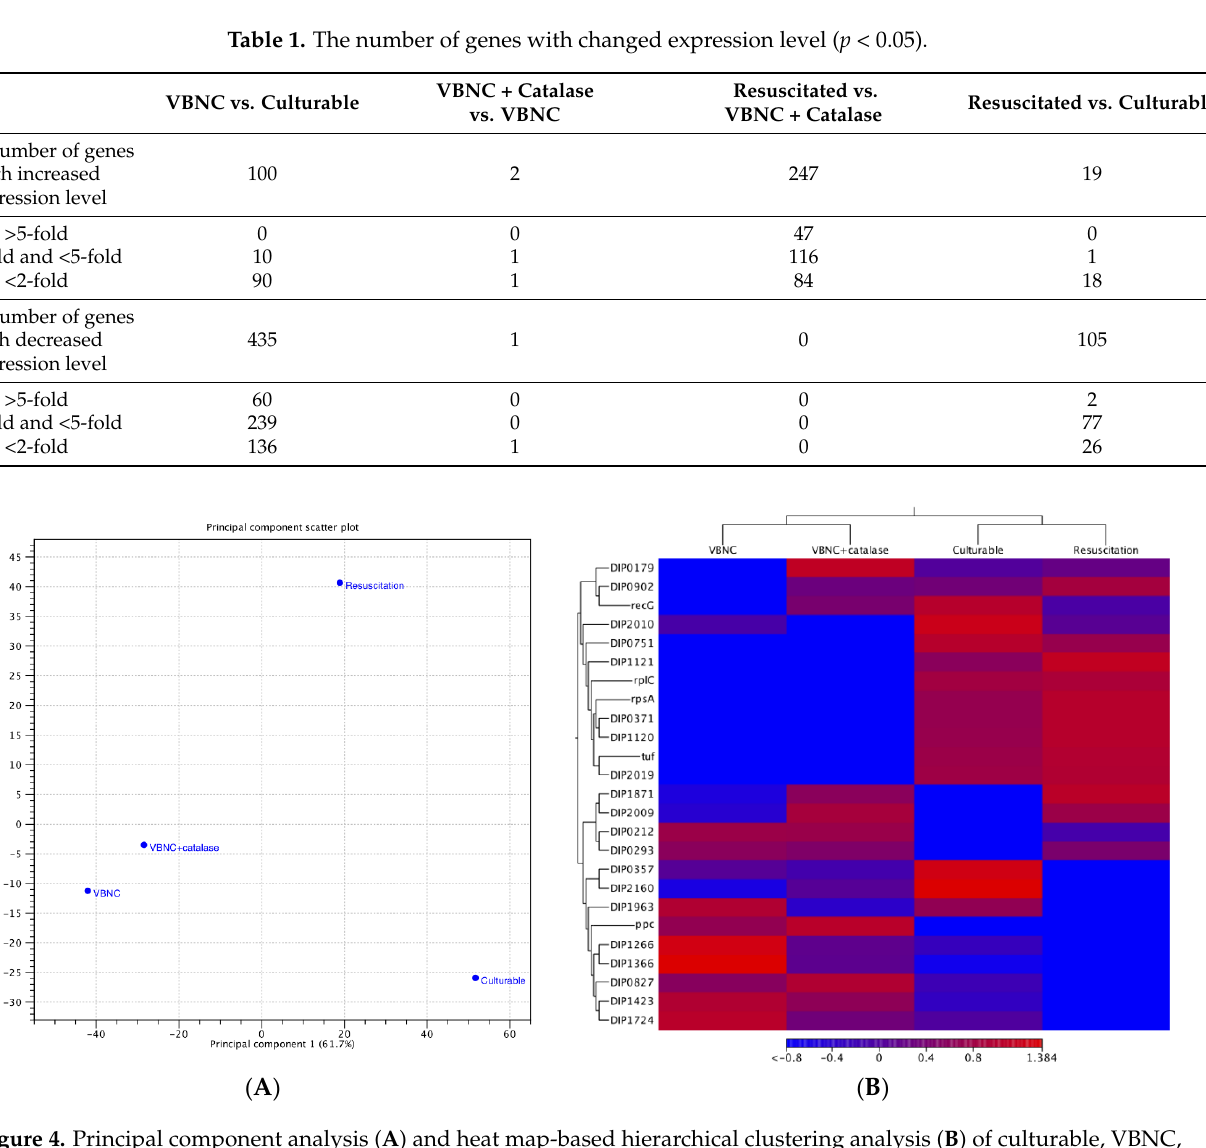
Figure 4. Principal component analysis ( A ) and heat map-based hierarchical clustering analysis ( B ) of culturable, VBNC, VBNC + catalase, and resuscitated C. diphtheriae ATCC700971. These results were obtained by analyzing two independent experimental data with CLC Genomic Workbench version 20 software.